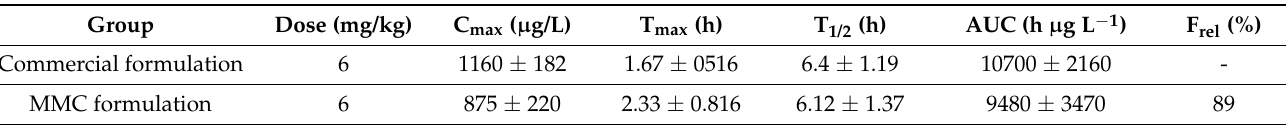
Table 1. Summary of calculated pharmacokinetic parameters. The values are an average of n = 6 animals per group. Abbreviations: C max , maximum concentration; T max , time to reach maximum concentration; T 1/2 , terminal half-time; AUC, area under the